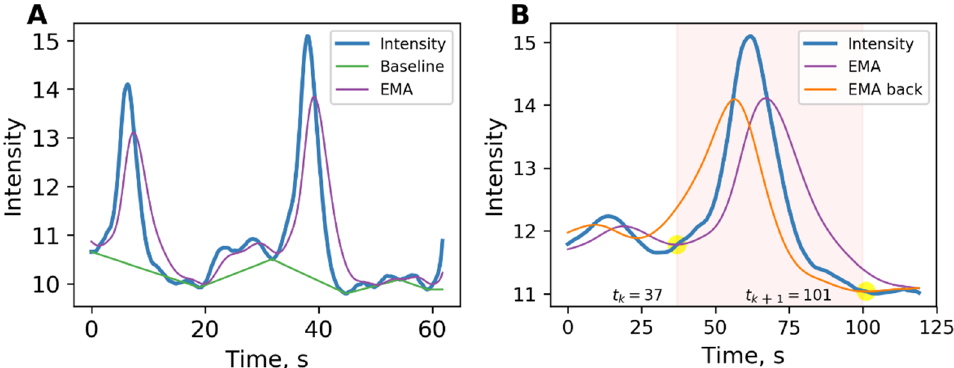
Figure 1. ( A ) Intensity signal shown in blue. EMA (exponential moving average) is used to find the baseline. ( B ) Method of searching for the start and finish of an event. The moment when the intensity signal (shown in blue) crosses the violet EMA line is taken as the start of the event. The moment when the intensity signal crosses the orange EMA back line is taken as the finish of the event. Event time highlighted in pink.